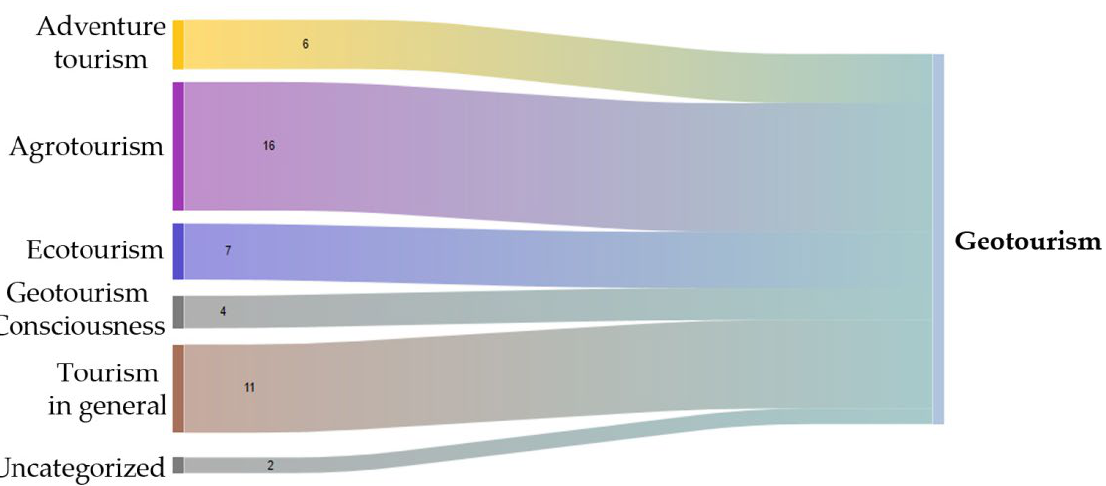
Figure 7. Graph of students’ perceptions (codes) on the concept of geotourism (Sankey diagram).